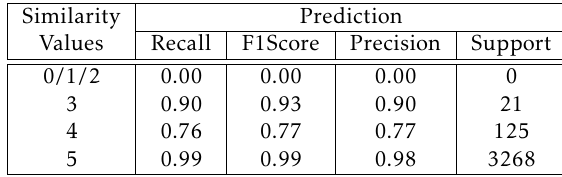
Figure 4. Comparison of Transitivity Outcomes in existing models.